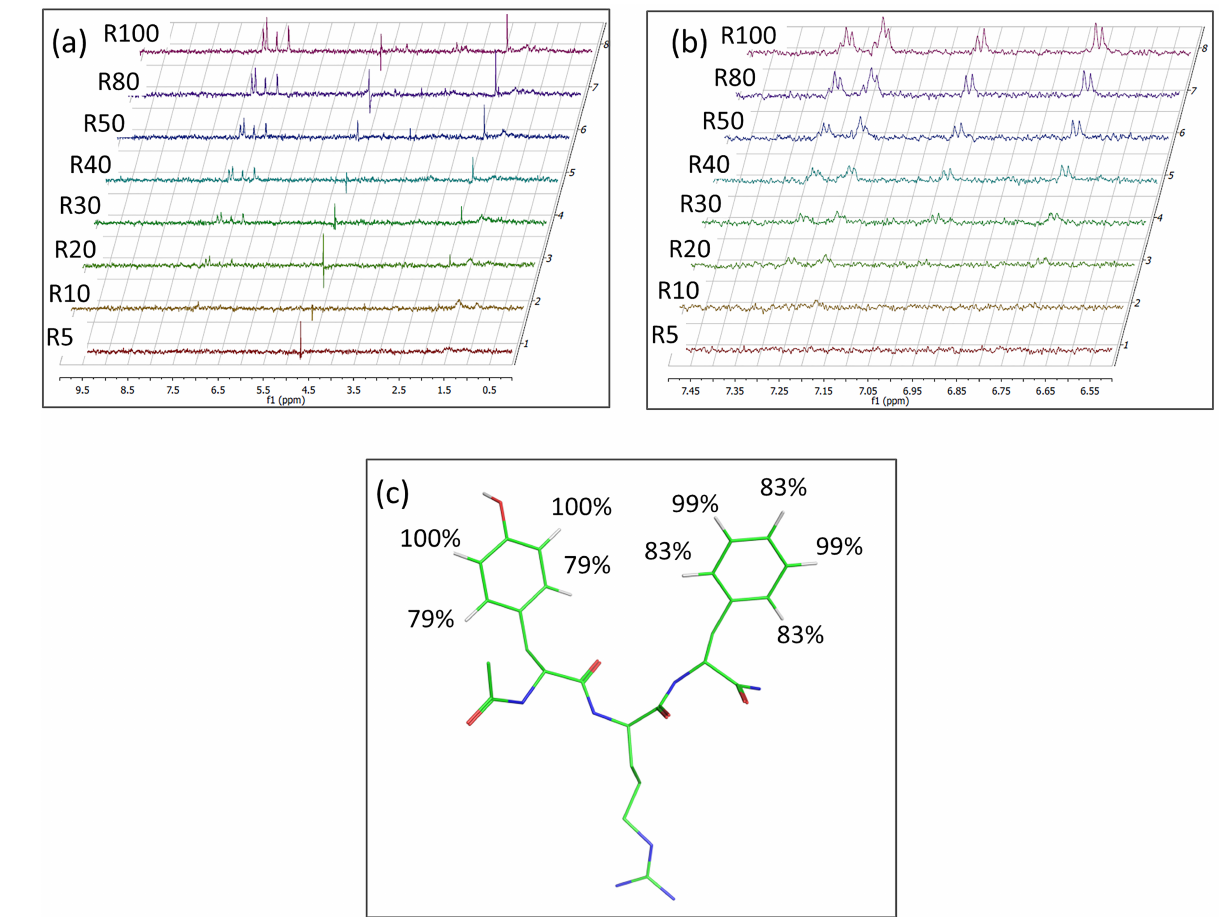
Figure 3. ( a ) STD spectra acquired at 10 µM of MKK7-KD and DTP3/MKK7-KD ratio values in the range 5 ÷ 100; ( b ) Zoom-in of the aromatic region; ( c ) Molecular model of DTP3 reporting the group epitope mapping (GEM) at